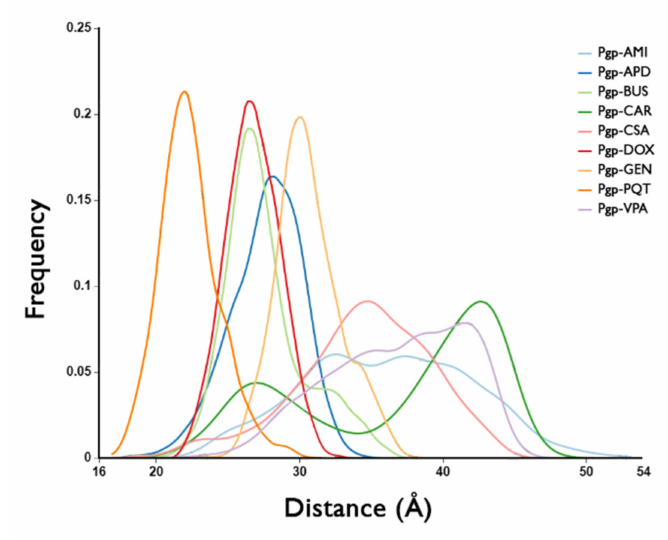
Figure 10. NBDs’ distance distribution curves over all of the trajectories for the studied systems.